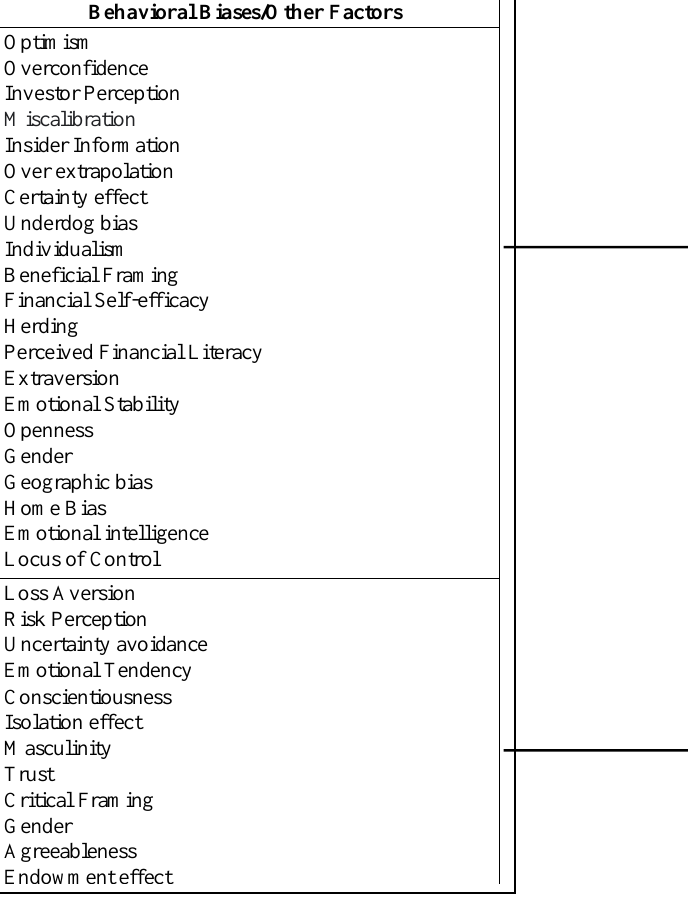
Figure.6. Investors’ Biases & Risk Profiling Source: Author’s own